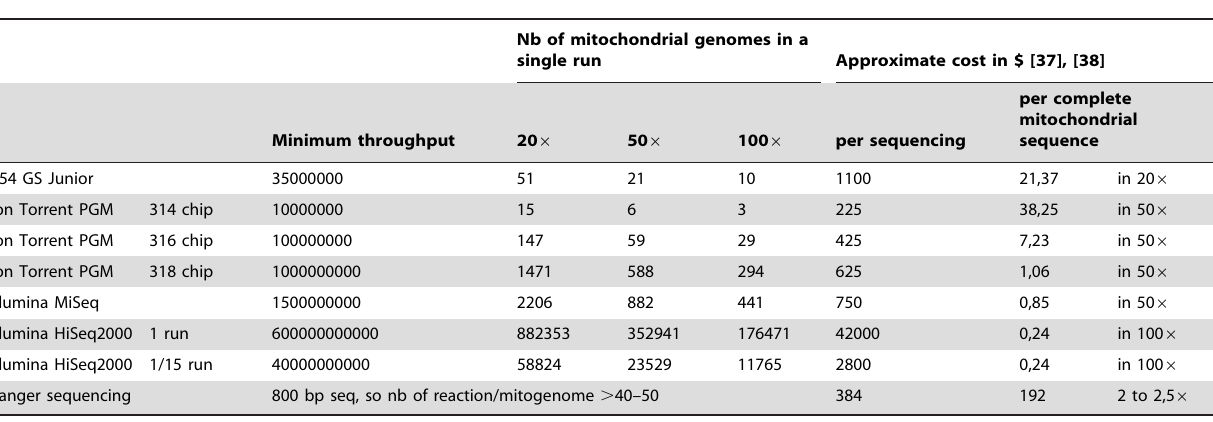
Table 2. Complete mitogenome output for two next generation sequencers, with rough estimate of the